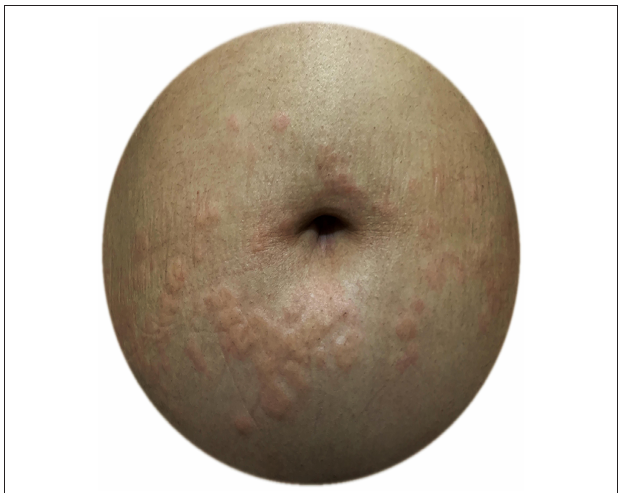
FIGURE 4 | A pregnant CU patient with exacerbation of urticaria in the third trimester; urticarial plaques around the umbilicus.